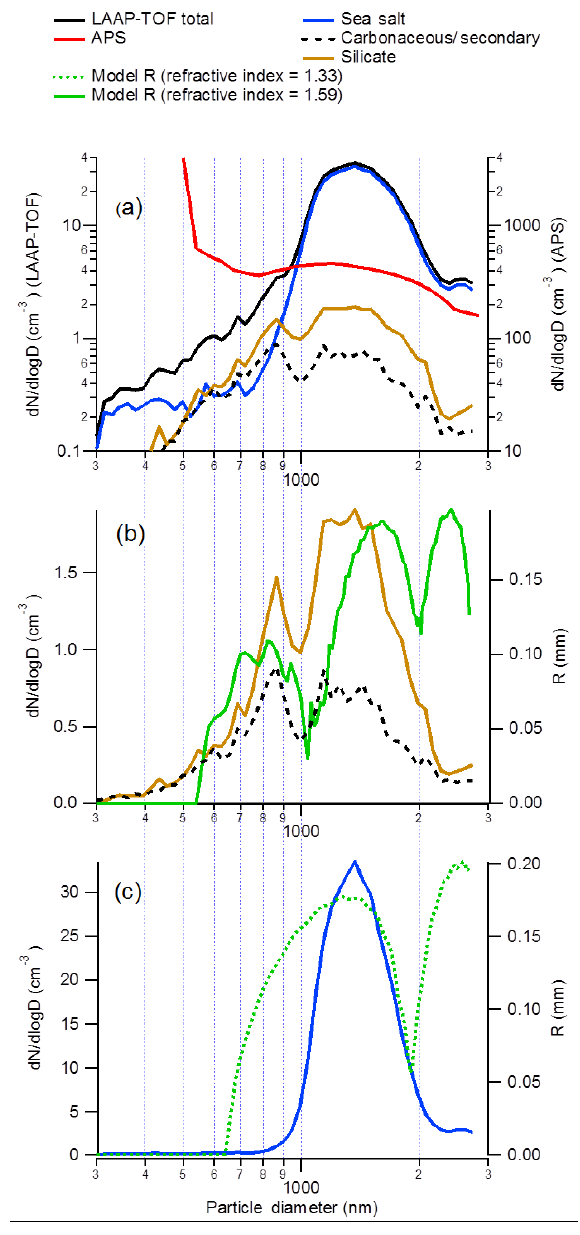
Figure 12. Particle size distributions measured by the LAAP-TOF and an aerodynamic particle sizer (APS) at Praia, Cabo Verde, dur- ing the ICE-D campaign. (a) The vacuum aerodynamic diameter size distribution of the total number concentration and main parti- cle composition classes measured by the LAAP-TOF compared to the aerodynamic size distribution measured by the APS. (b) The carbonaceous/secondary and silicate size distributions compared to the modelled effective detection radius of optical detection stage 2 (refractive index: 1.59; collection angle: 10–12 ◦ ). (c) The sea salt size distributions compared to the modelled effective detection ra- dius of the second optical detection stage (refractive index: 1.33; collection angle: 10–12 ◦